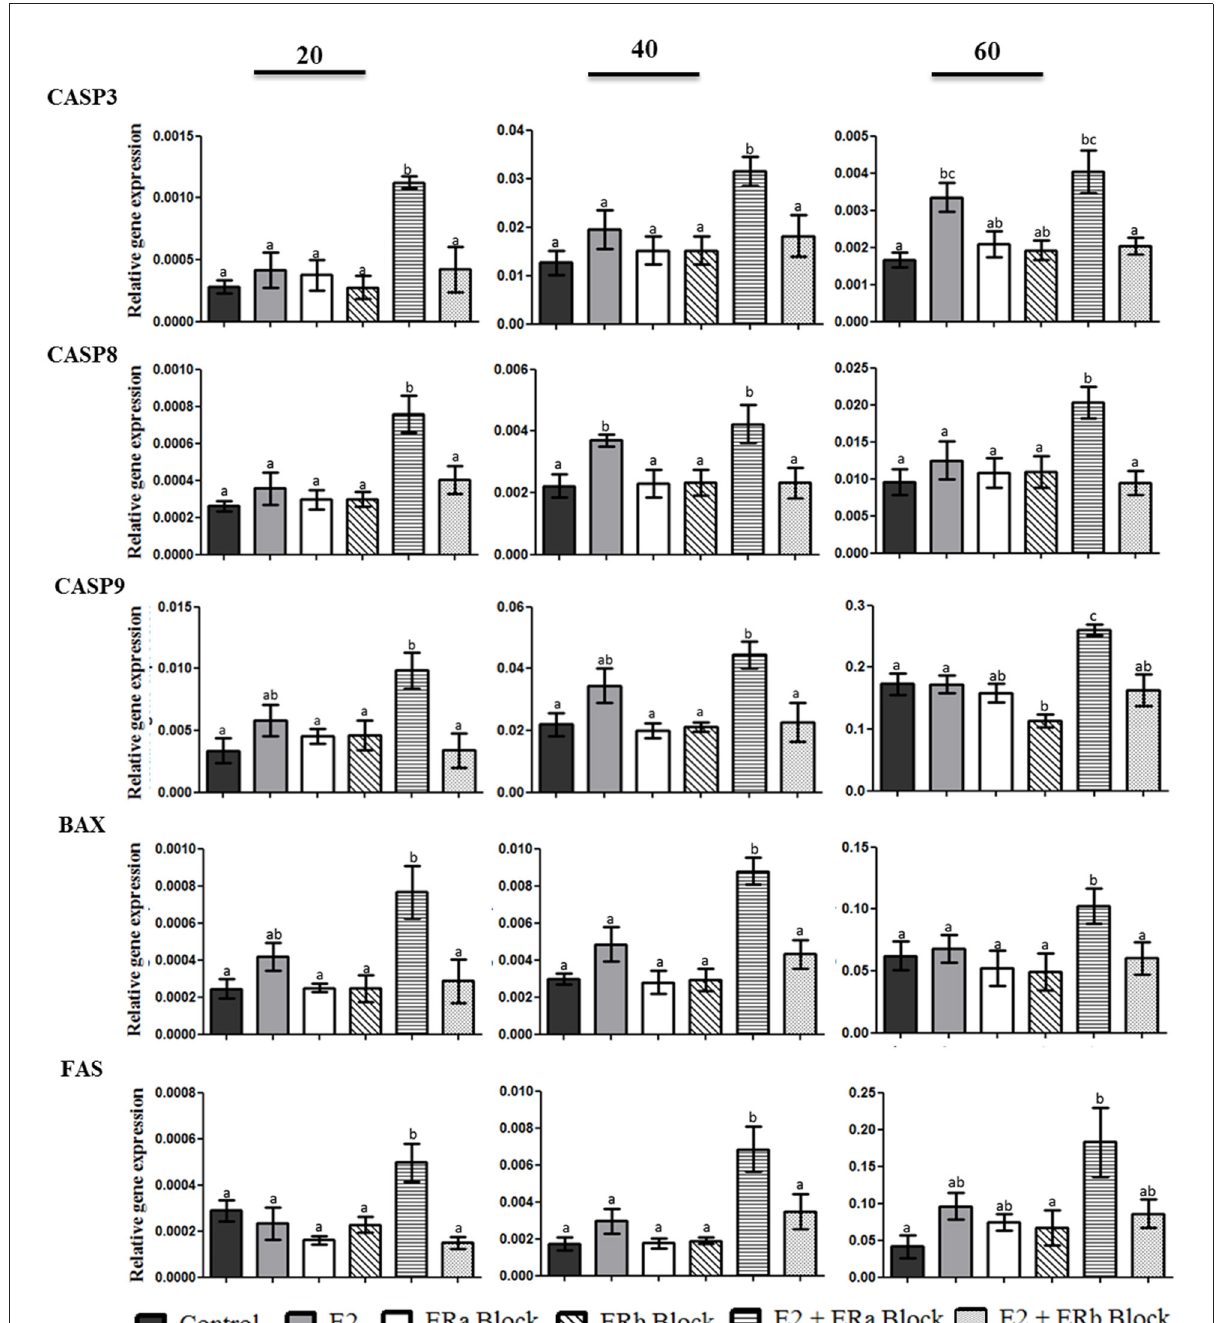
FIGURE7 Gene expression of CASP3 , CASP8 , CASP9 , BAX , and FAS in canine luteal cells collected on days 20, 40, and 60 after ovulation and cultivated for 10 days until confluence was reached. Bars indicate six different groups: Control, E2 (treated with E2), ERa block (treated with methyl-piperidino-pyrazole [MPP]), ERb block (treated with pyrazolo (1,5-a) pyrimidine [PHTPP]), E2 + ERa block (treated with E2 + MPP), and E2 + ERb block (treated with E2 + PHTPP). Data represent mean ± standard error of relative gene expression ( n = 4 animals/group). Bars with different letters indicate significant differences among groups ( P <